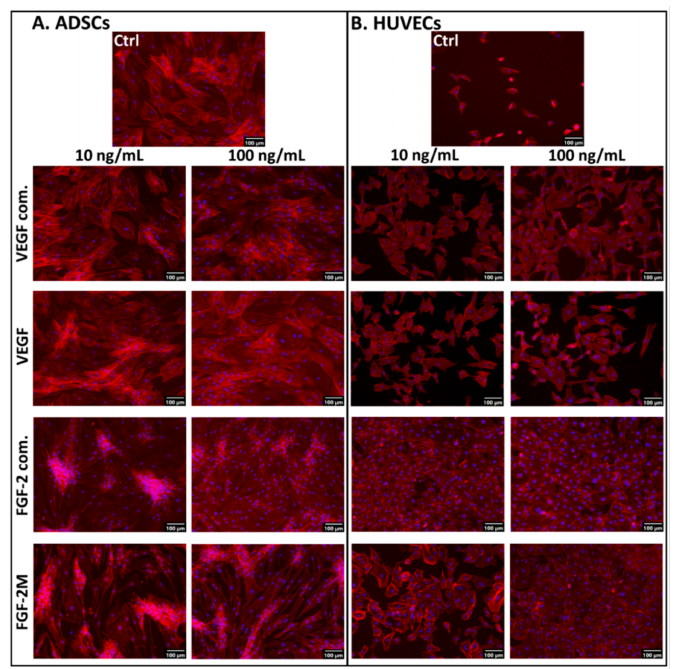
Figure 2. Microphotographs of ADSCs ( A ) and HUVECs ( B ) on day 7 after seeding in media enriched with commercial VEGF-A 165 (VEGF com.) or our recombinant VEGF-A 165 , and in media enriched with commercial FGF-2 (FGF-2 com.) or our recombinant FGF-2M. The growth factors were added into DMEM with 10% FBS for ADSCs and into EGM2-weak for HUVECs. Representative low and high concentrations (i.e., 10 ng/mL and 100 ng/mL, respectively) of the tested growth factors were selected. Control cells were grown in media without growth factors (Ctrl). The filamentous actin in cells was stained with phalloidin-tetramethylrhodamine (TRITC) to visualize the cell morphology. The nuclei were counterstained with Hoechst 33258. Olympus IX 71 microscope, DP 70 digital camera, obj. 10 × , scale bar 100 µ